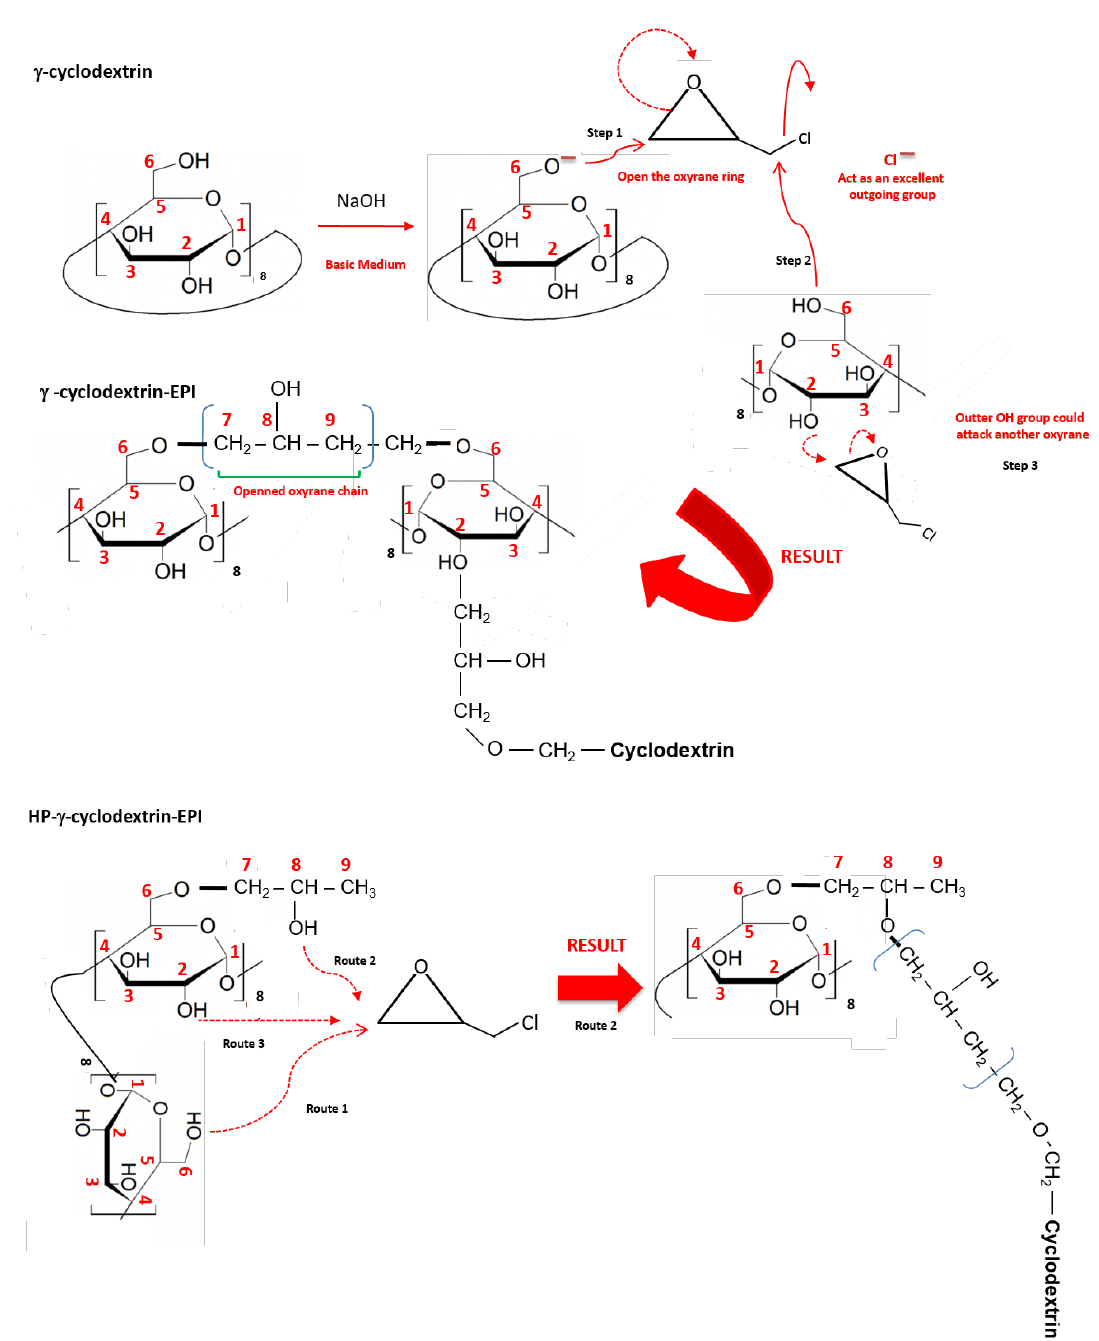
Figure 1. Scheme of reactions taking place between cyclodextrins (CDs) and epichlorohydrin (EPI).